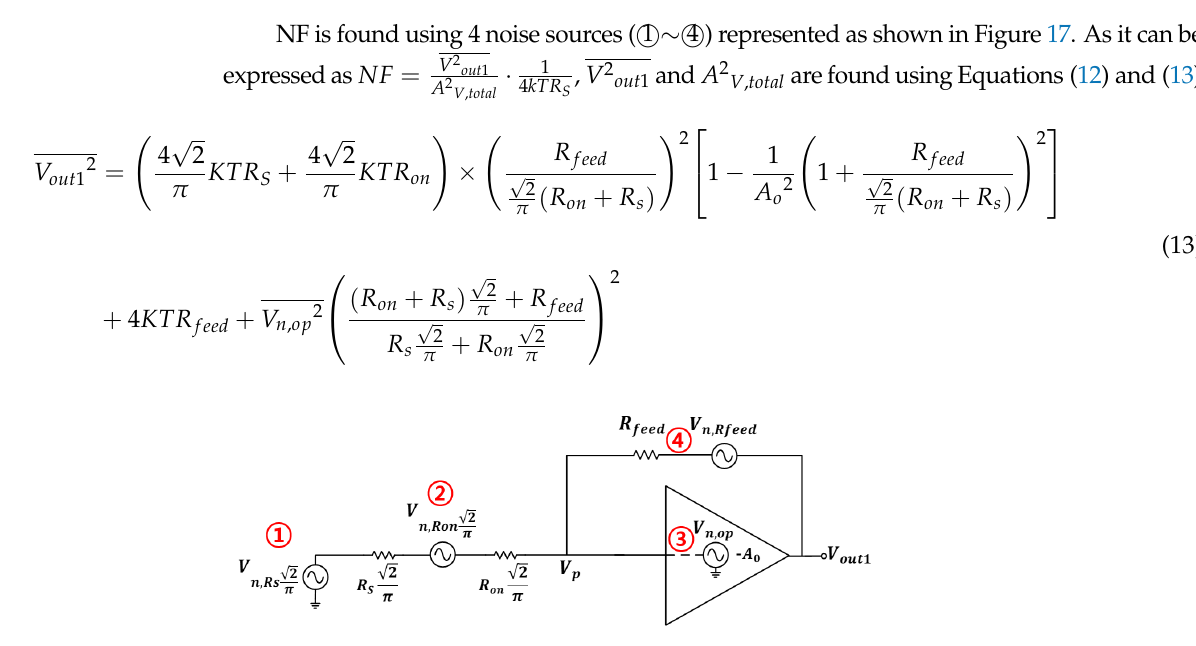
Figure 17. Equivalent noise analysis using half circuit modeling. Substituting the Equations (12) and (13) into NF = V figure can be expressed by Equation